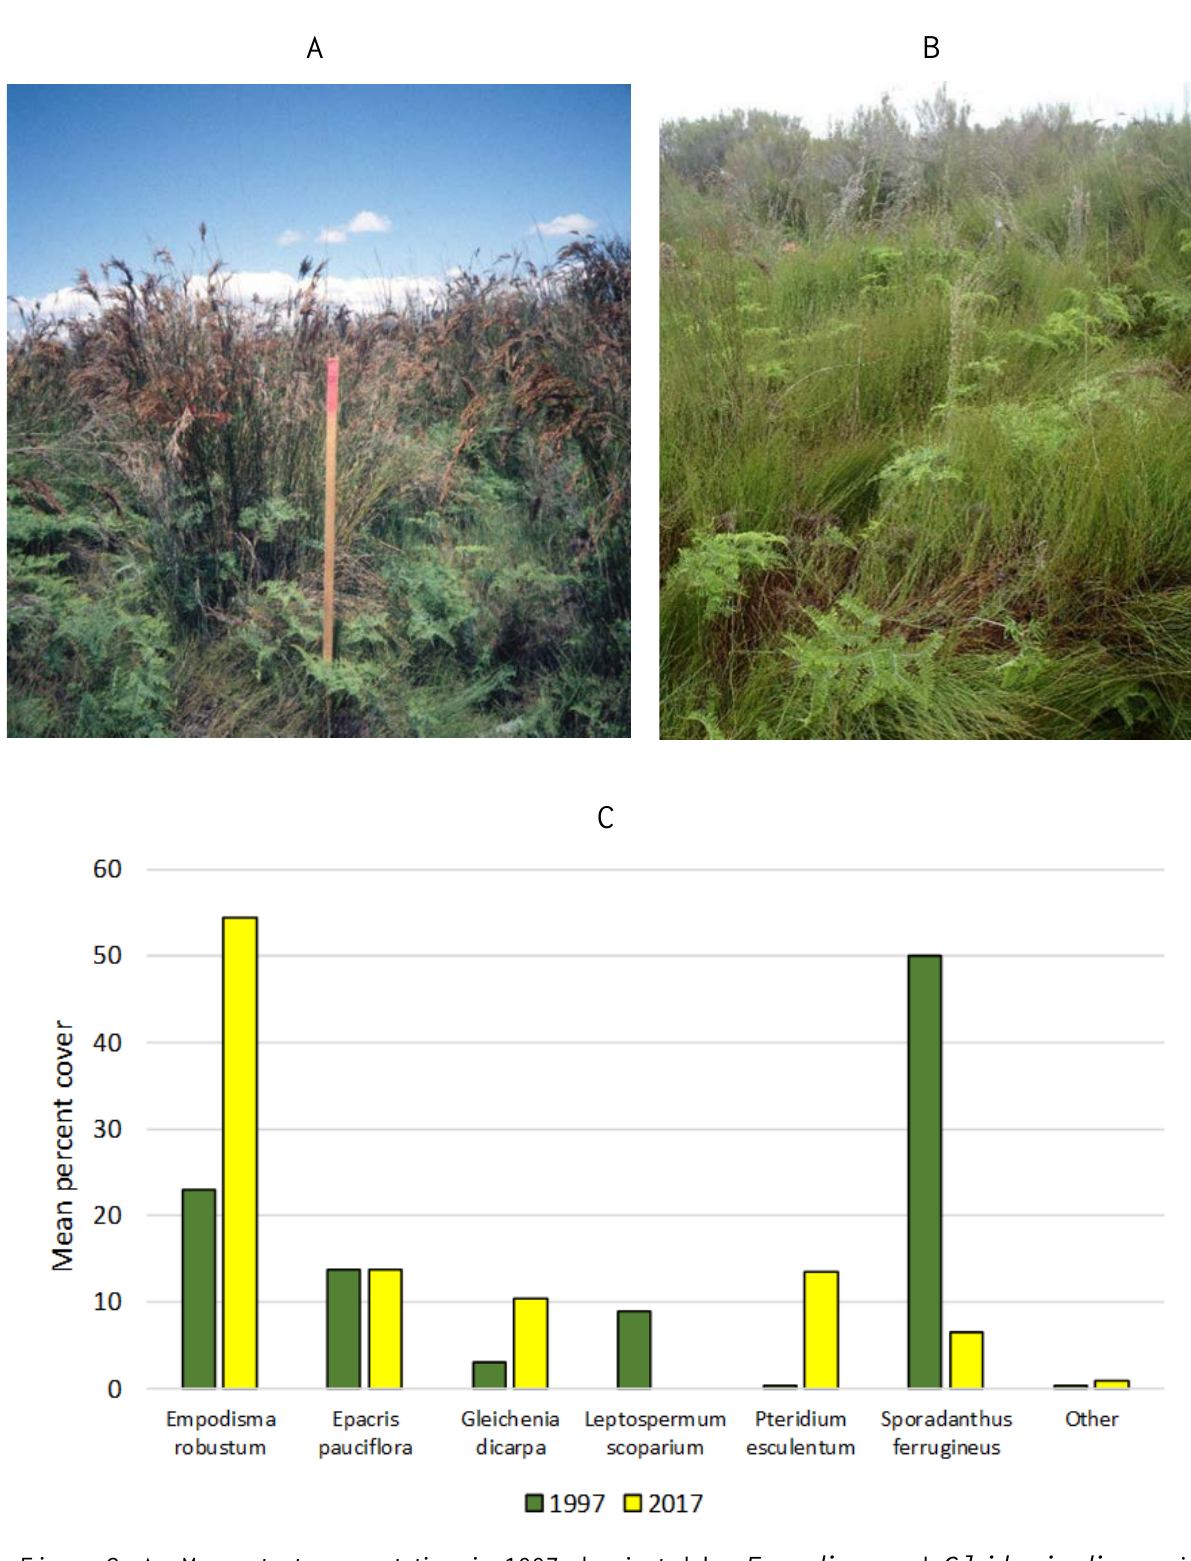
Figure 2. A: Moanatuatua vegetation in 1997 dominated by Empodisma and Gleichenia dicarpa in foreground, and the taller Sporadanthus in background. The wooden stake is 2 m tall. B: Moanatuatua vegetation in the same general area in 2017 showing Empodisma and Gleichenia dicarpa in foreground and Epacris shrubs in background, with scattered culms of Sporadanthus (e.g., upper mid left), recognisable by the tall brown rush-like flower heads. C: Clustered column chart of transect species mean percent cover at Moanatuatua in 1997 and 2017; ‘Other’ = Drosera binata (1997), Histiopteris incisa (2017) and Hypolepis distans